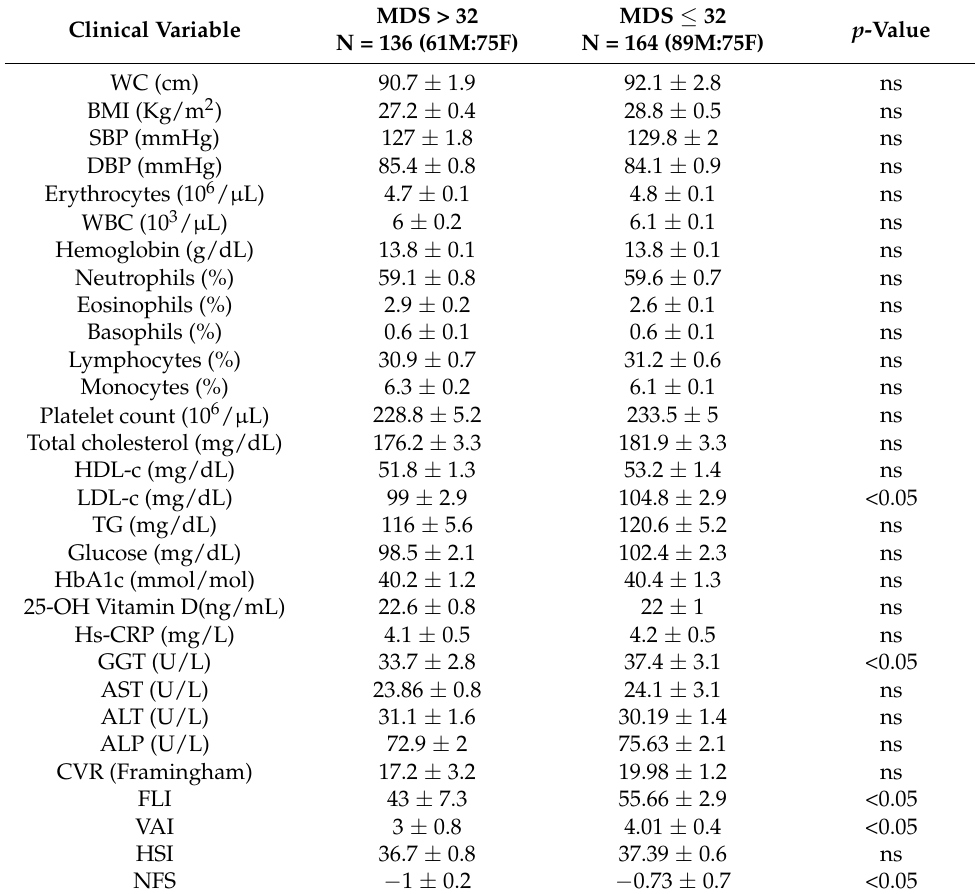
Table 2. Comparison of subgroups identified according to Med Diet Score (MDS) above and under the ROC-identified cut-off for pathologic visceral obesity assessed as increased waist circumference.